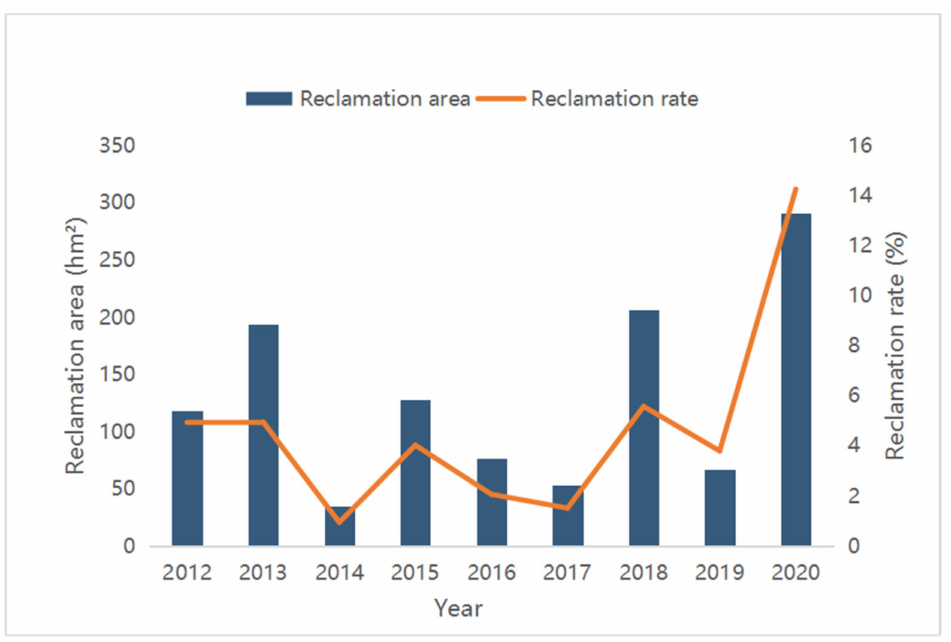
Figure 9. Area and rate of re-cultivation of abandoned farmland in Luquan for the period of 2012–2020.